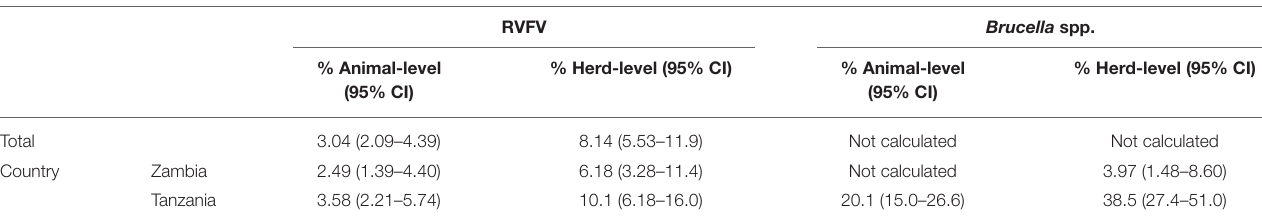
TABLE 8 | True animal- and herd-level seroprevalence for RVFV and Brucella